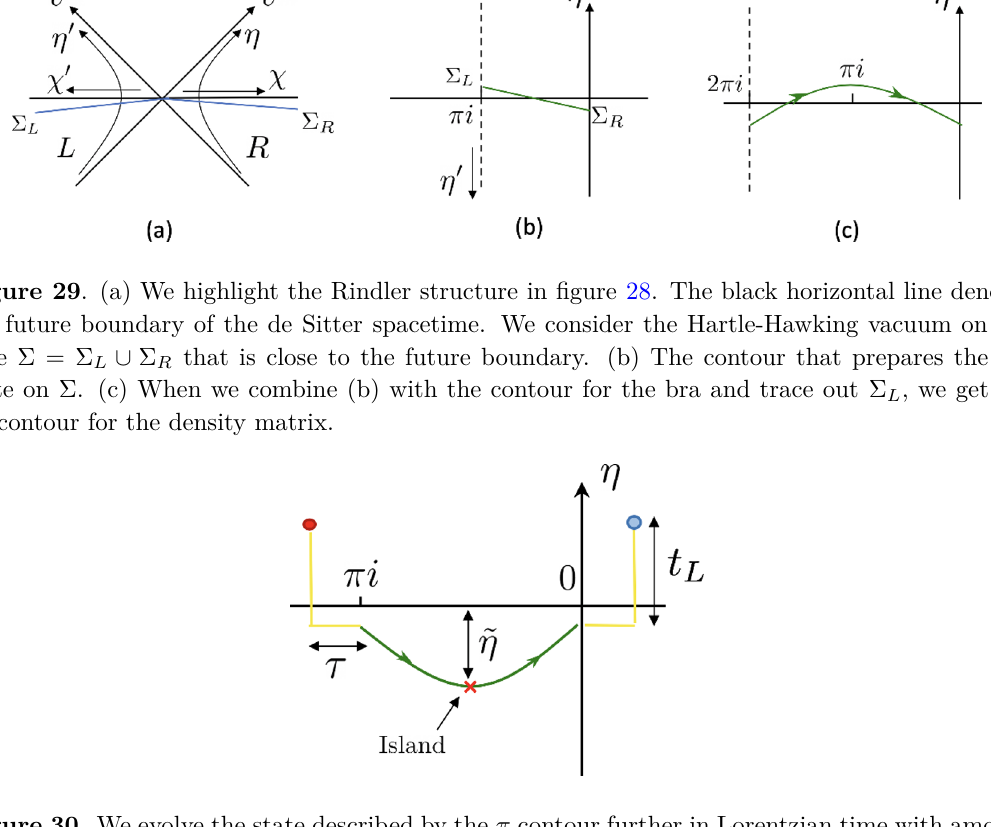
Figure 30 . We evolve the state described by the π contour further in Lorentzian time with amount t L , after an Euclidean regularization with amount τ . The possible location of the island is marked by the red